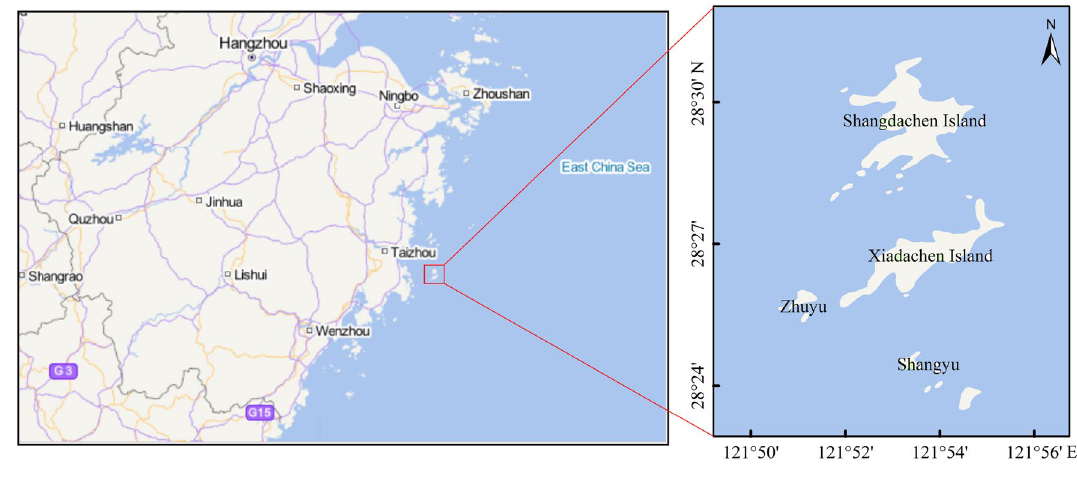
Figure 1. Map of the study